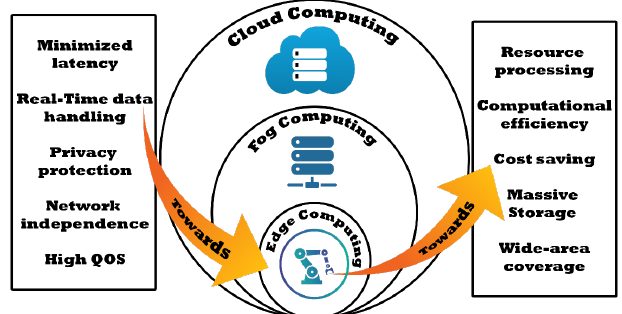
Figure 2. Salient Features of Edge and